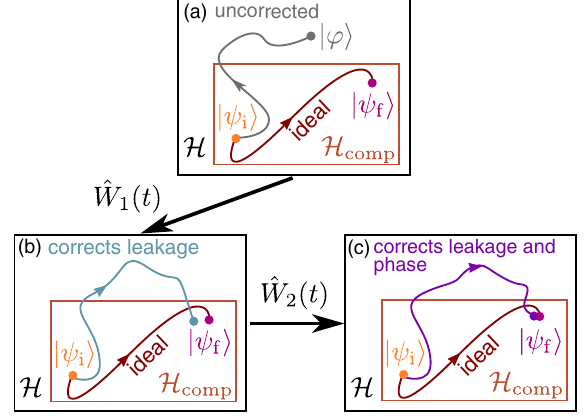
FIG. 1. Schematic representation of the Magnus-based algo- rithm. (a) Before applying the algorithm, the ideal evolution is corrupted by the spurious coupling, which prevents it from reaching the target state j ψ . (b) After the first step of the f i Magnus-based algorithm, “ pure ” leakage errors are canceled ˆ W on average by the control Hamiltonian 1 ð t Þ . Although the system ends in H at t , the target state j ψ is not reached. comp f f i (c) The second step of the Magnus-based algorithm corrects induced phase errors within H with the help of the control comp ˆ W Hamiltonian 2 ð t Þ